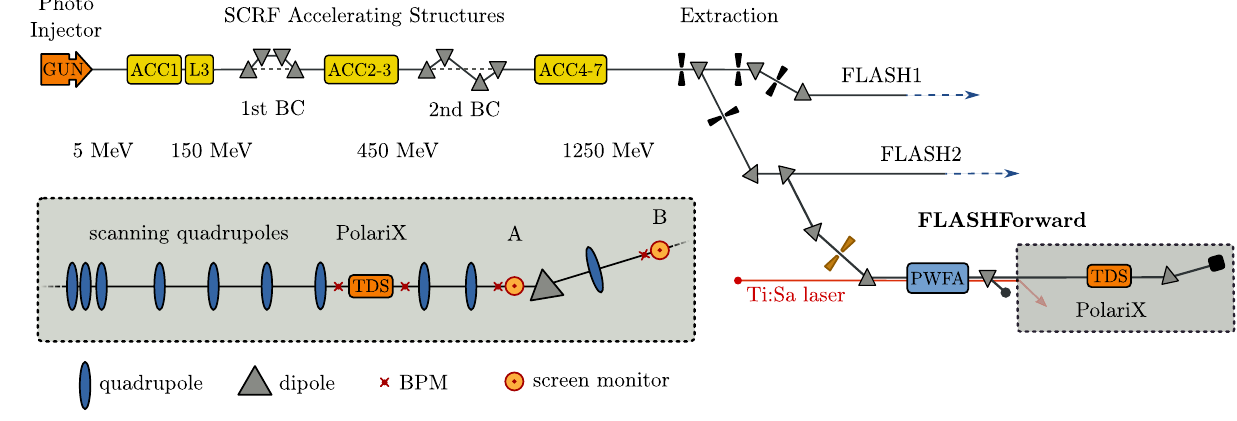
Figure 2. FLASH beamline layout with the three coexisting beamlines: FLASH1, FLASH2 and FLASHForward. A schematic layout of the PolariX-TDS diagnostics beamline is shown inside the dashed box with gray background. The quadrupoles upstream of the TDS are used to scan the phase advance in the slice emittance measurement. Screen stations marked with A and B correspond to 11FLFXTDS (slice emittance screen) and 8FLFDUMP (longitudinal phase space screen)